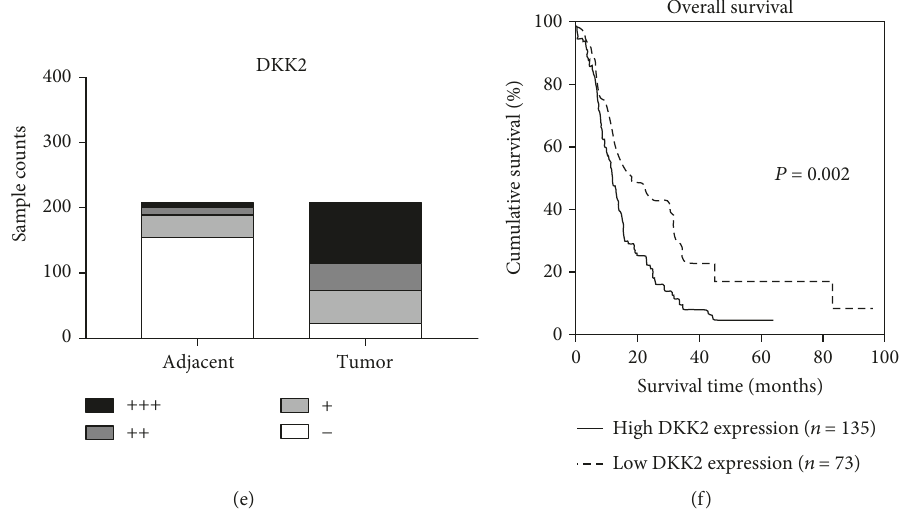
Figure 1: DKK2 was highly expressed in PDAC and was associated with poor prognosis in PDAC patients. (a, b) The mRNA expression level between tumor tissue and adjacent normal tissue in GSE15471 dataset, TCGA data, Oncomine, GTEx data, and Renji cohort. (c) DKK2 expression plot of various types of cancer from TCGA database. (d) Representative scoring criterion images of immunohistochemical staining of DKK2 expression in 208 paired PADC tumor and adjacent nontumor tissues. Scale bar: 50 μ m. (e) DKK2 was upregulated in PDAC tumor tissues. (f) High DKK2 expression correlated with inferior survival time. Abbreviations: TCGA: The Cancer Genome Atlas; GTEx: Genotype-Tissue Expression. Signi fi cant di ff erences are indicated as ∗ P < 0 05 ; ∗∗∗∗ P < 0 0001